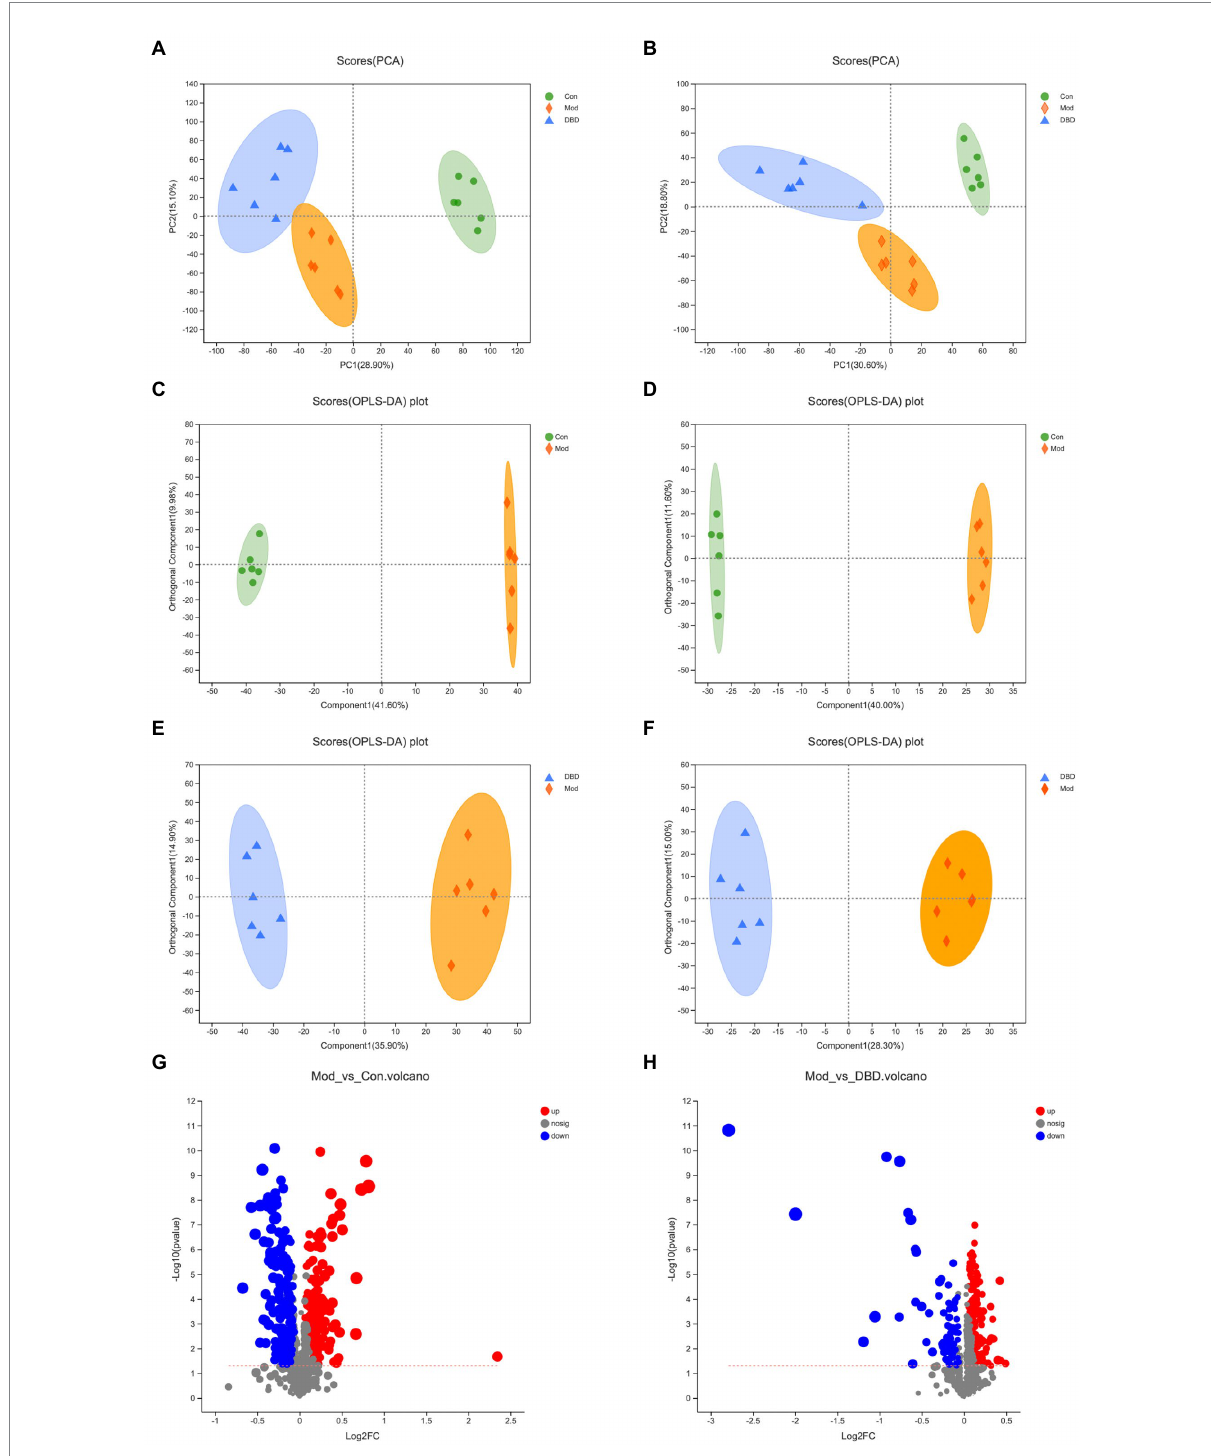
FIGURE 3 Multivariate statistical analysis of the LC–MS spectra of rat cecal contents taken from the three groups ( n = 6). (A) PCA score map of the three groups in the negative ion model. (B) PCA score map of three groups in the positive ion model. (C) OPLS-DA score map of control vs. model group in the negative ion model. (D) OPLS-DA score map of control vs. model group in the negative ion model. (E) OPLS-DA score map of control vs. model group in the negative ion model. (F) OPLS-DA score map of control vs. model group in the negative ion model. (G) Differential volcanic map of control vs. model group. (H) Differential volcanic map of model vs. DBD